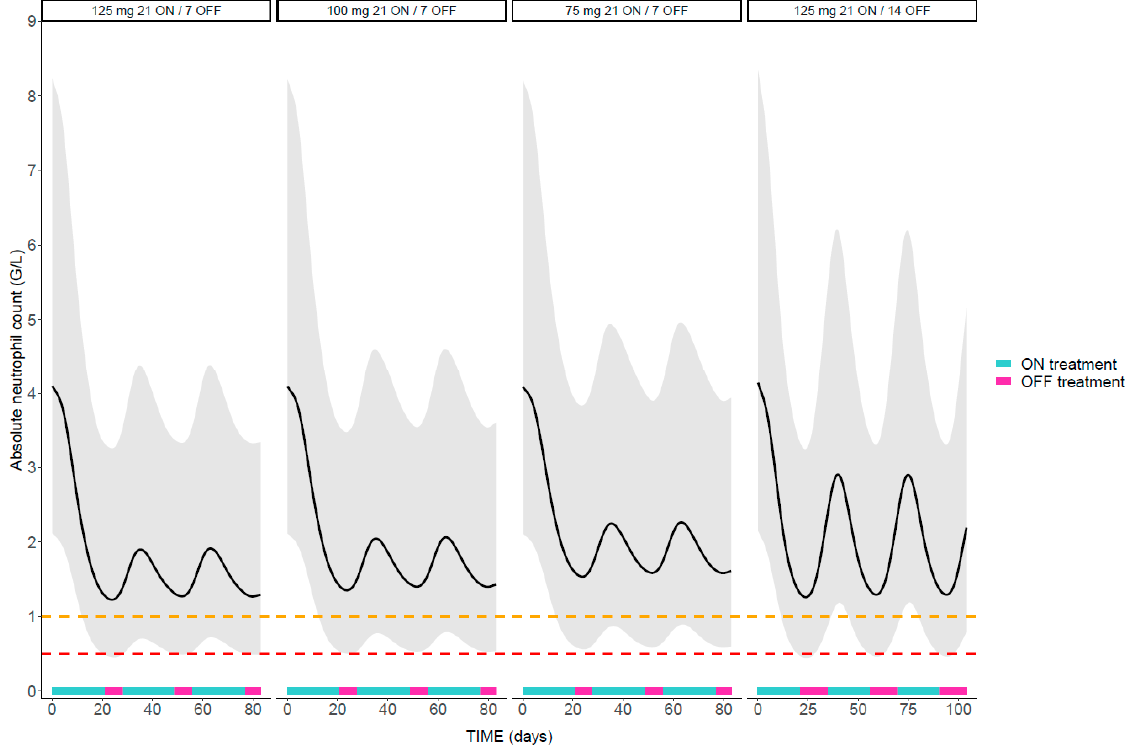
Figure 4. Model-based simulations of ANC dynamics following 3 cycles of different palbociclib dosage regimens (125, 100, or 75 mg, and 7- or 14-days OFF-treatment periods). The orange and red dotted lines represent the ANC threshold for grade 3 and 4 neutropenia, respectively. The black lines represent the population median prediction, and the shaded areas show the 95% prediction intervals.